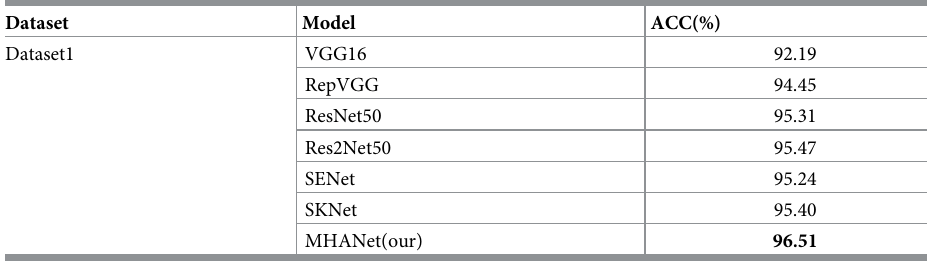
Table 5. Accuracy of Dataset2.